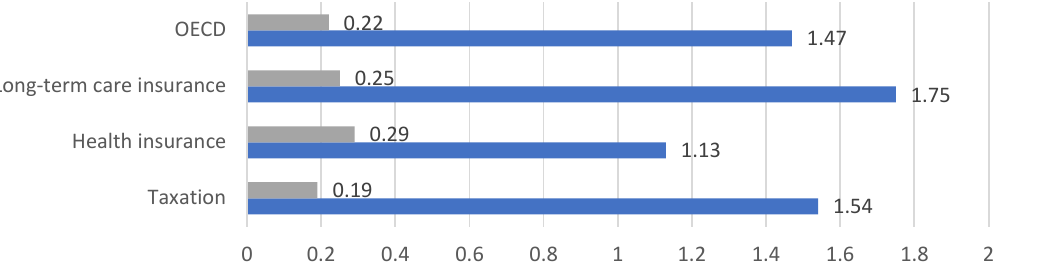
Figure 2. Status of long-term care expenditure as a percentage of GDP in 26 OECD countries (2019). Source: OECD Health Statistics [18].